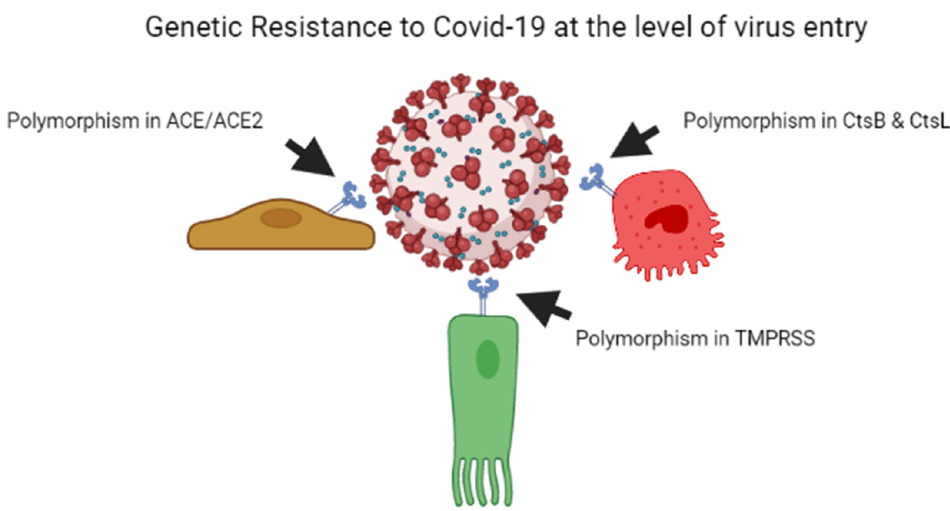
Figure 1. Genetic resistance of host against the COVID ‐ 19 virus at the level of entry of the virus. Similarly, an ecological analysis found that having a higher I/I genotype frequency was linked to lower COVID ‐ 19 mortality in 25 nations worldwide [74]. In Asian popula ‐ tions, numbers of the D allele were determined by the number of SARS ‐ CoV ‐ 2 infected patients per million [75]. In Asian populations, mortality rates and the presence of the D allele revealed the substantial positive connection, demonstrating that greater levels of ACE are harmful to COVID ‐ 19 patients [75]. COVID ‐ 19 infection and fatality rates are both greater in the European population [73]. Since, the ACE DD genotype is more com ‐ mon in Europeans than in Asians, higher death rates in Europeans are likely to be ac ‐ counted by ethnic variations in ACE I/D polymorphism allele prevalence. 2.1.2. Angiotensin Converting Enzyme ‐ 2 Angiotensin ‐ I and Angiotensin ‐ II are cleaved into peptides such as Angiotensin 1–9 and Angiotensin 1–7, respectively, by ACE2, the master regulator of the RAS. These pep ‐ tides are essential components in cardiovascular physiology control [76,77]. SARS ‐ Cov ‐ 2 infection suppresses ACE2 expression and interferes with its homeostatic and defensive actions, causing inflammation [78]. ACE2 is present at various levels in most human tis ‐ sues [79,80]. As SARS ‐ CoV ‐ 2 attacks alveolar epithelial cells via the ACE2 receptor, the ACE2 expression levels in different organs might reveal genetic sensitivity to COVID ‐ 19 [81,82]. Single ‐ cell RNA sequencing of various cell types in lung tissue revealed that bron ‐ chial branches contain a transient cell population with the ACE2 phenotype. Among these cells, 40% also express the transmembrane serine protease 2 (TMPRSS2) involved in the priming of the viral spike protein, thus making these cells more vulnerable to COVID ‐ 19 infection [83]. The ACE2 gene contains the regulatory elements for chromatin alteration and tran ‐ scription factors that regulate expression levels epigenetically and hormonally. In several tissues, there is a link between ACE2 expression and age, gender, ethnicity, and BMI [84]. Asian females have the most significant connection with age, followed by sex and ethnic groupings. In a study of 305 people, the expression of the ACE2 gene in the nasal epithe ‐ lium was explored, and it was discovered that younger children under the age of ten have the lowest ACE2 levels [85]. As a result, it was hypothesised that the reduced risk in